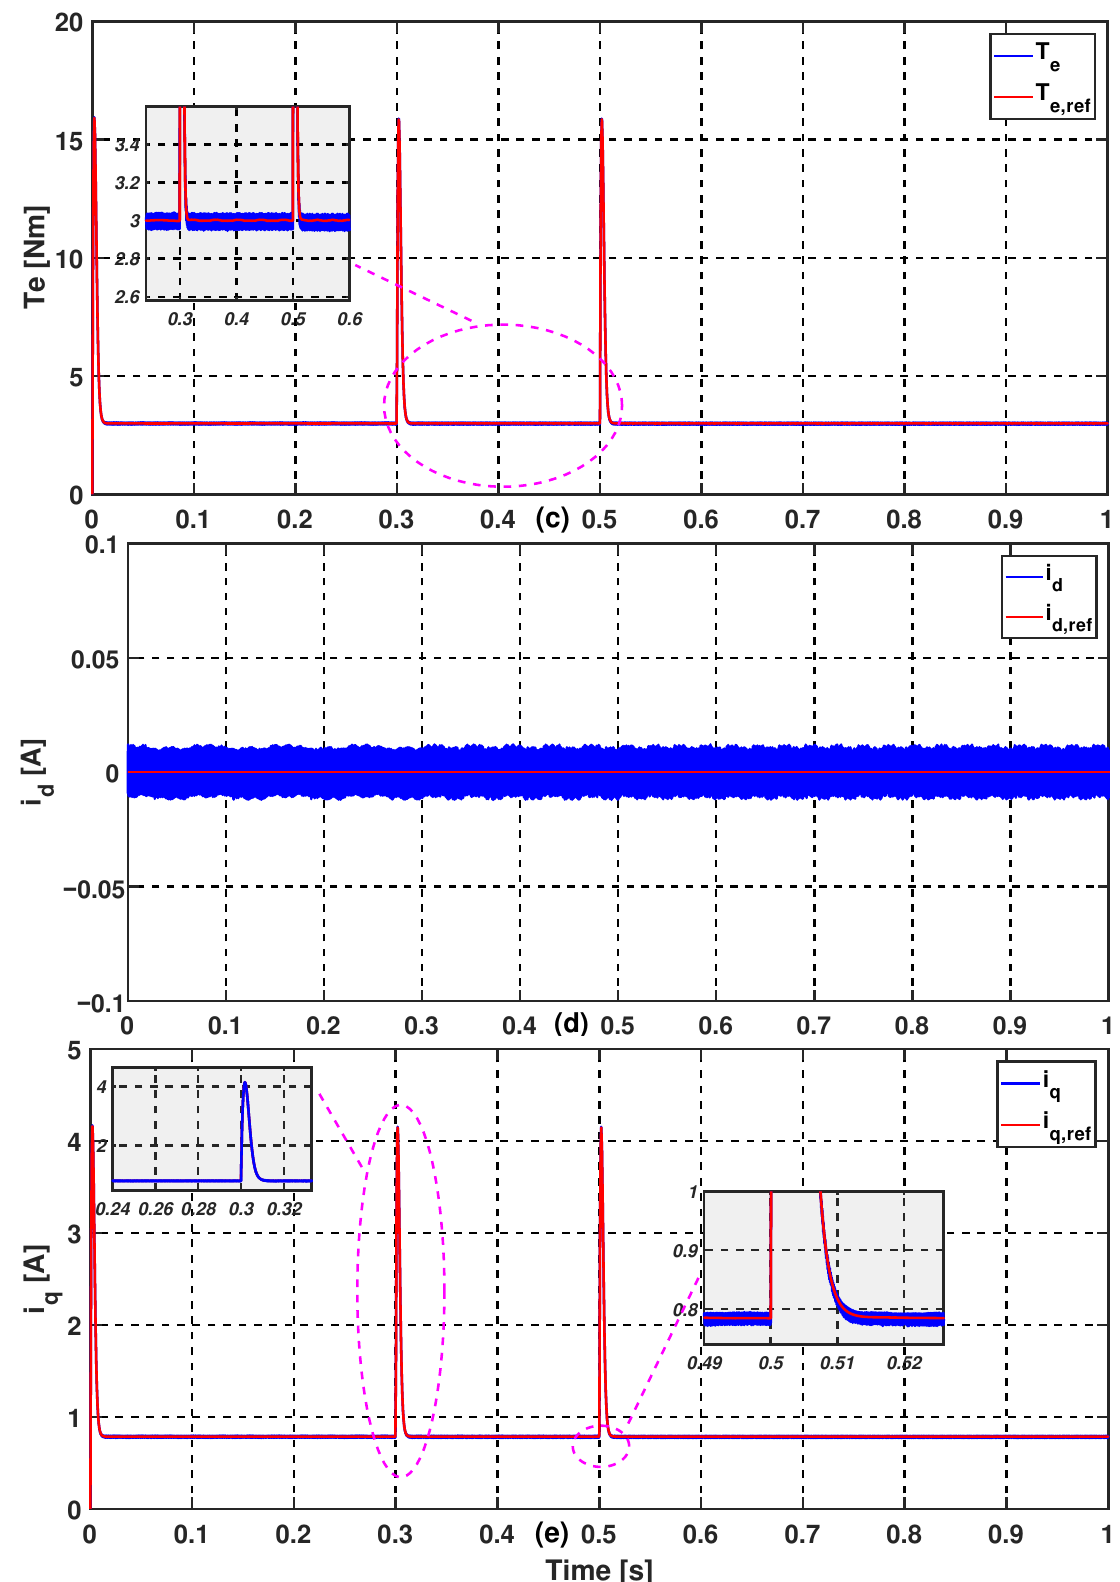
Figure 10. Performances of the proposed multiple-vector 3VV FCS-MPC applied on PMSM drive system (from top): ( a ) Speed ( ω m , ω m , ref ), ( b ) tracking error ( ∆ ω m ), ( c ) electromagnetic torque ( T e , T e , ref ), ( d ) direct current ( I d , I d , ref ), and ( e ) quadratic current ( I q , I q , ref